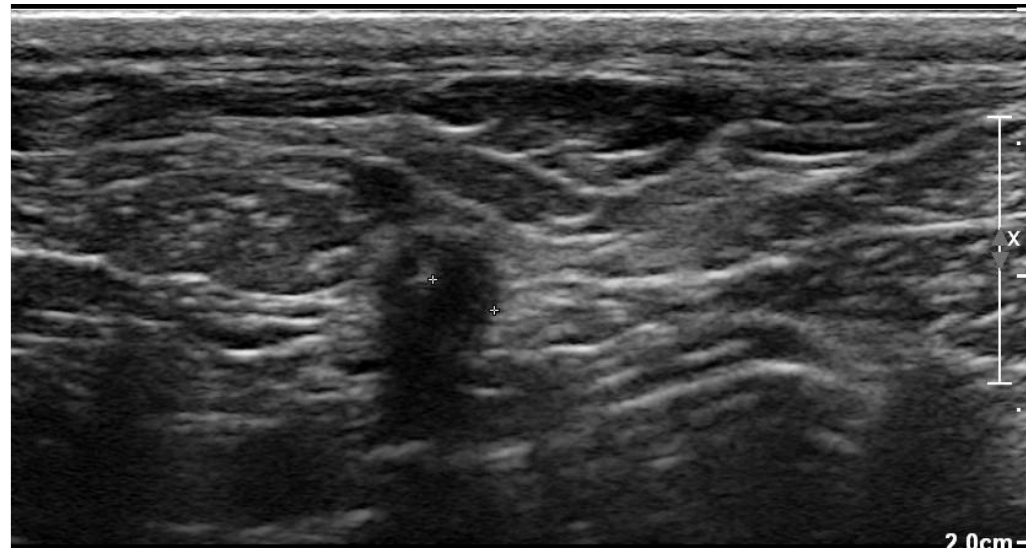
Figure 9. Two-dimensional grayscale ultrasonographic image at the site of the previous swelling at the level of the jugular venous access shows a hypoechoic tissue of about 2.5 mm adjacent to the pacing lead, which is displayed in cross section.